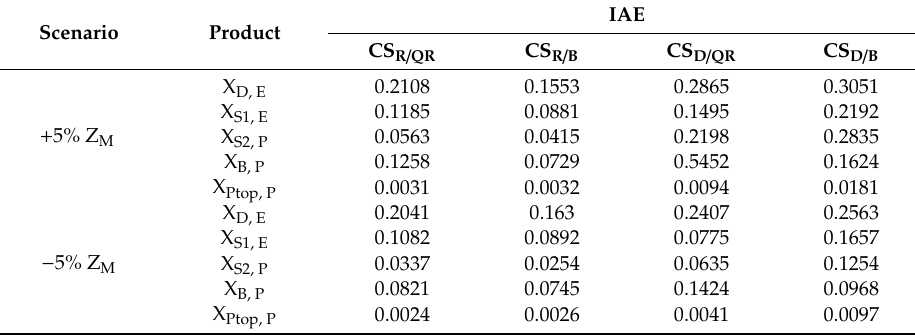
Table 3. Integrated absolute error (IAE) of the Controlled Components for a ±5% Variation in the Composition of Components M, E, P, and B.